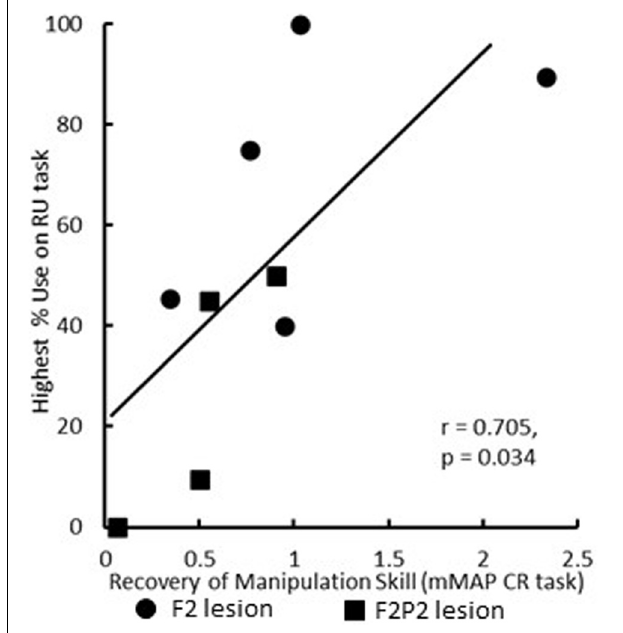
FIGURE 6 | Scattergraph showing the relationship between average percentage use of the contralesional hand in the RU task after the first attempt and recovery of manipulation skill in the mDB best well (BW) task. Each plotted point is for a single monkey. Note that SDM70 had a very high manipulation skill recovery ratio that was primarily due to very low variability in performance scores. This monkey also had a very high average percentage success in the RU task, resulting in a spuriously high correlation with recovery of manipulation skill.